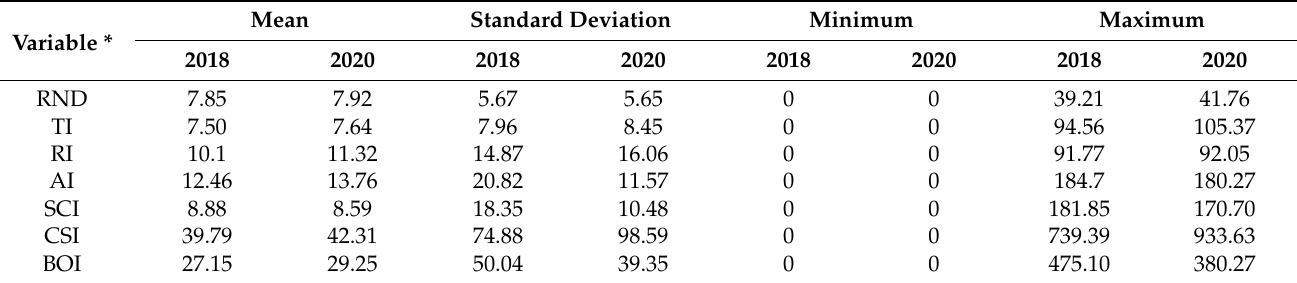
Table 2. Descriptive statistics for variables in this study.